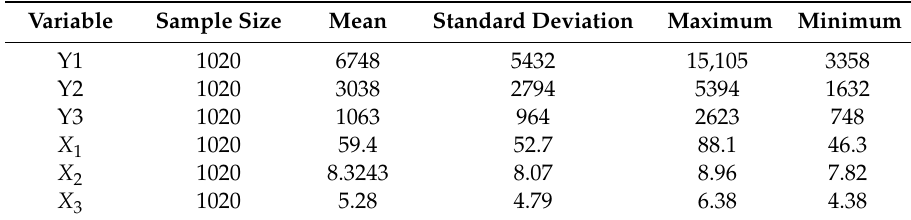
Table 5. Variable descriptive statistics.